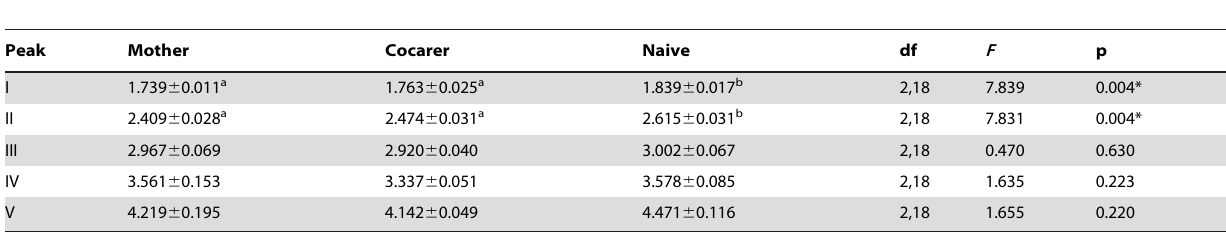
Table 1. Click-evoked ABR peak latencies measured 20 dB above each animal’s threshold.